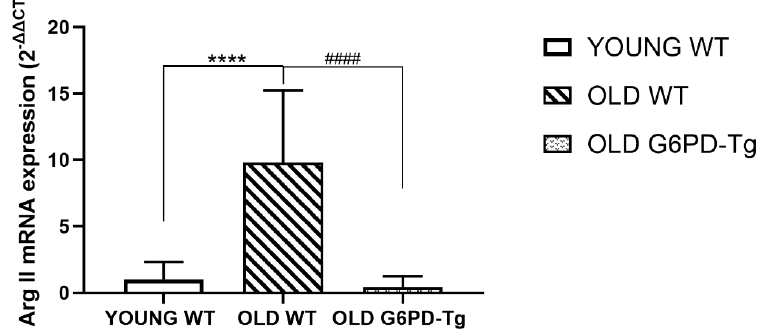
Figure 2. eNOS gene expression in aortic rings from old WT and old Tg mice groups studied. Results are expressed as fold change (2 −ΔΔ Ct ) and are the geometric mean with 95% CI ( n = 4 per group). * p < 0.05.